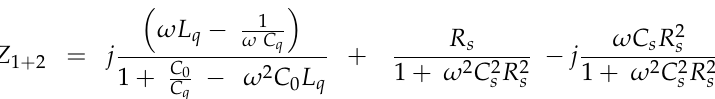
Figure 6. Response frequency of the annular microelectrode piezoelectric biosensor in KCl solution and the equivalent circuit model for the sensor. ( A ) Response frequency (curve 2: with 2 pairs annuluses; curve 3: with 3 pairs annuluses; curve 4: with 4 pairs annuluses; curve 5: with 5 pairs annuluses). ( B ) Equivalent circuit model of the sensor.